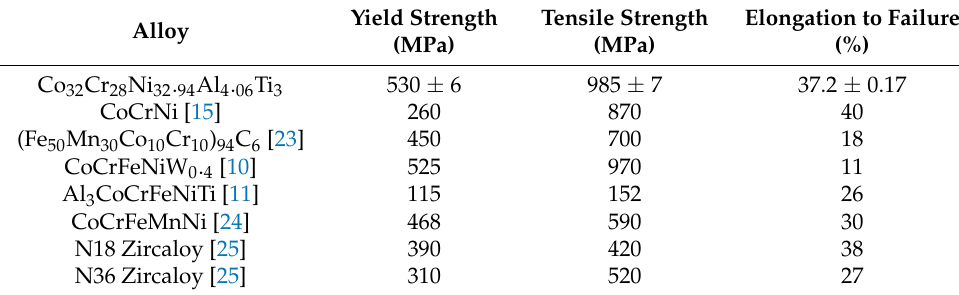
Table 5. Comparison of the tensile mechanical properties.